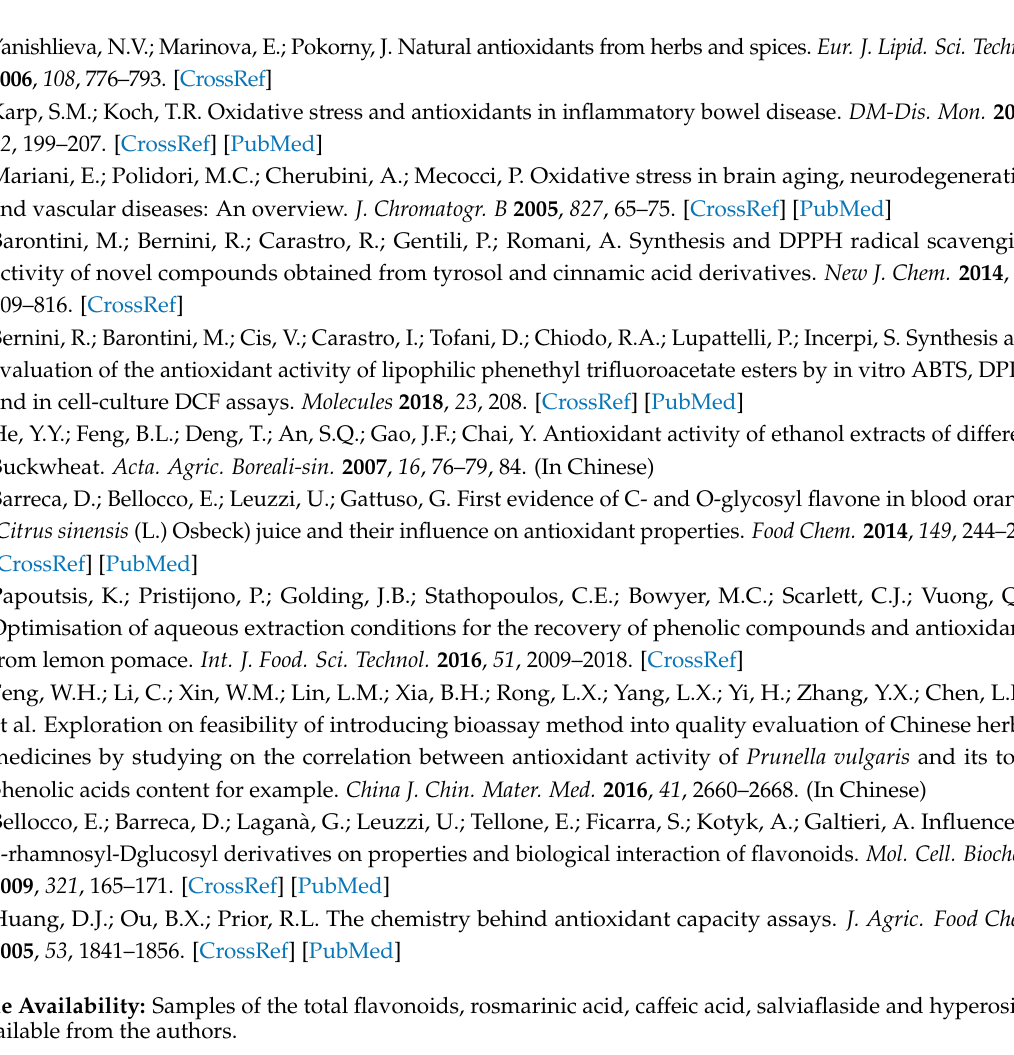
Sample Availability: Samples of the total flavonoids, rosmarinic acid, caffeic acid, salviaflaside and hyperoside are available from the